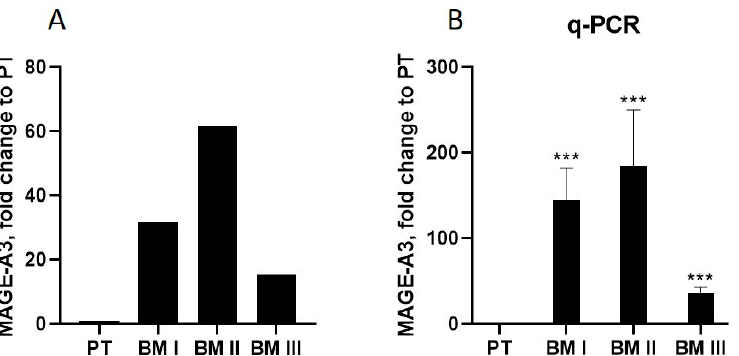
Figure 7. ( A ) The transcript showing the highest up-regulation in transcriptome analysis in the BM generations compared to PT was MAGE-A3. ( B ) Up-regulation of MAGE-A3 was confirmed by qPCR. Shown are mean + SEM of three independent experiments. *** p < 0.0001.